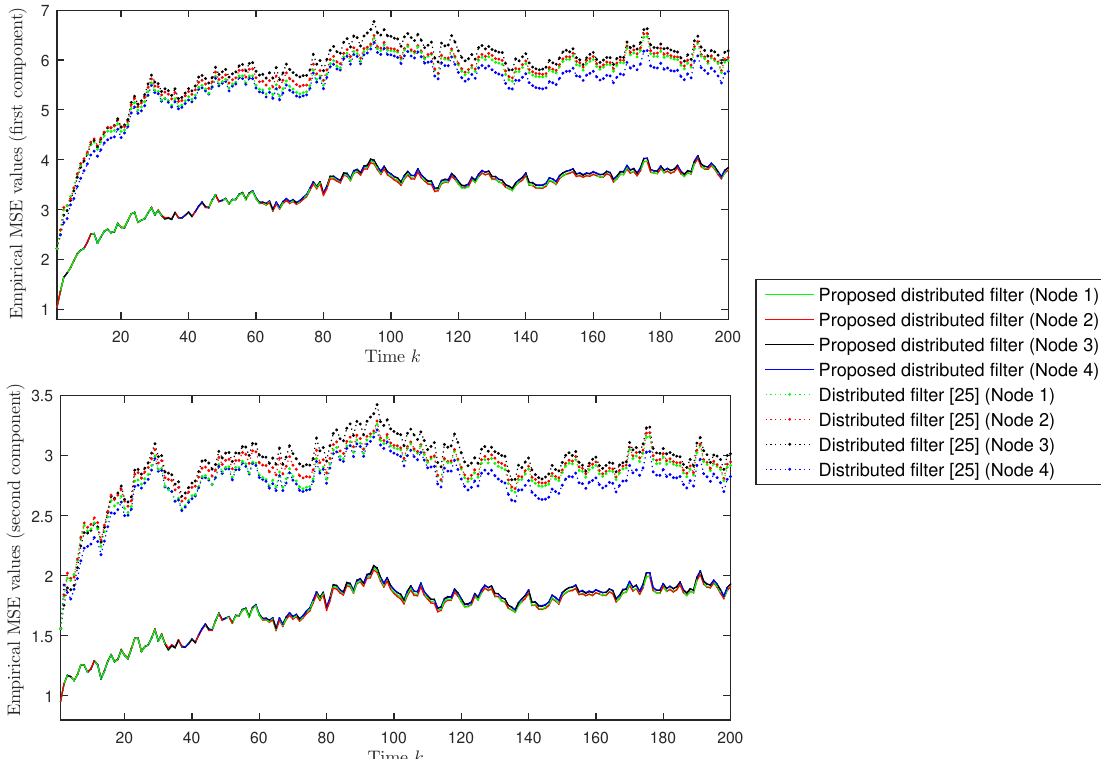
Figure 5. Empirical mean squared error comparison of the proposed distributed filter and the distributed filter in